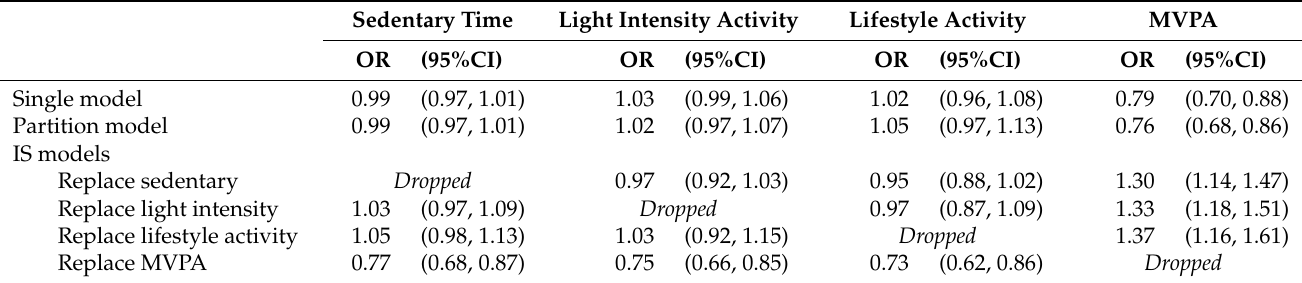
Table 4. Single factor, partition, and isotemporal substitution models examining the association of sedentary behavior, light and lifestyle, and MVPA with adverse cardiometabolic health ( ≥ 4 risk